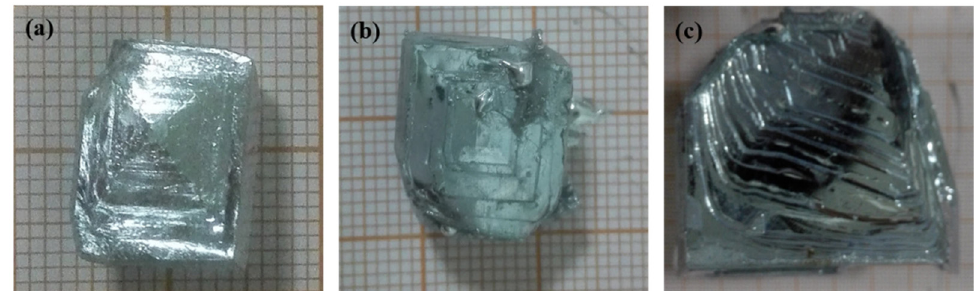
Figure 4. Morphological images of crystal blocks at di ff erent times after adding crystal seed (( a ) 15 min, ( b ) 30 min, and ( c ) 60 min).